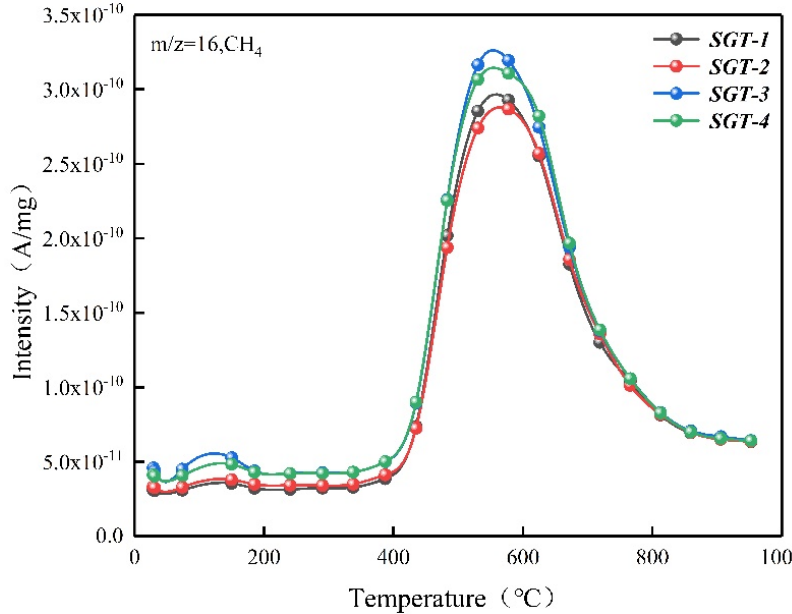
Figure 3. Evolution curves of CH 4.